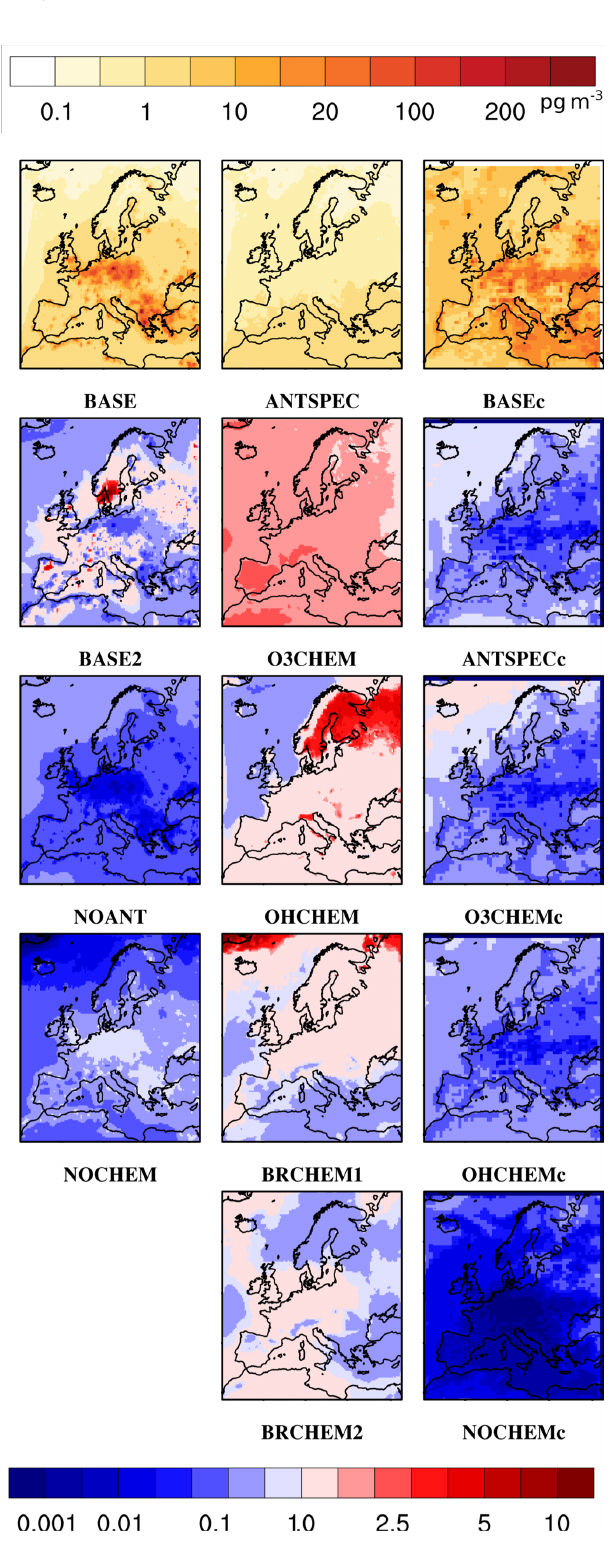
Figure 10. The annual RGM mean concentrations at ground level and the ratio of RGM in the sensitivity runs compared to BASE, ANTSPEC and BASE C . The mean RGM concentrations are shown in the first row for BASE, ANTSPEC and BASE C experiments (upper colour label), while the ratio (lower colour label) of these with the sensitivity runs is reported in the relative column: BASE2, NOANT and NOCHEM ratios (left column) are referred to the BASE experiment, O3CHEM, OHCHEM, BRCHEM1 and BRCHEM2 (central column) ratios refer to the ANTSPEC experiment, and ANTSPEC C , O3CHEM C , OHCHEM C and NOCHEM C (right column) ratios refer to the BASE C